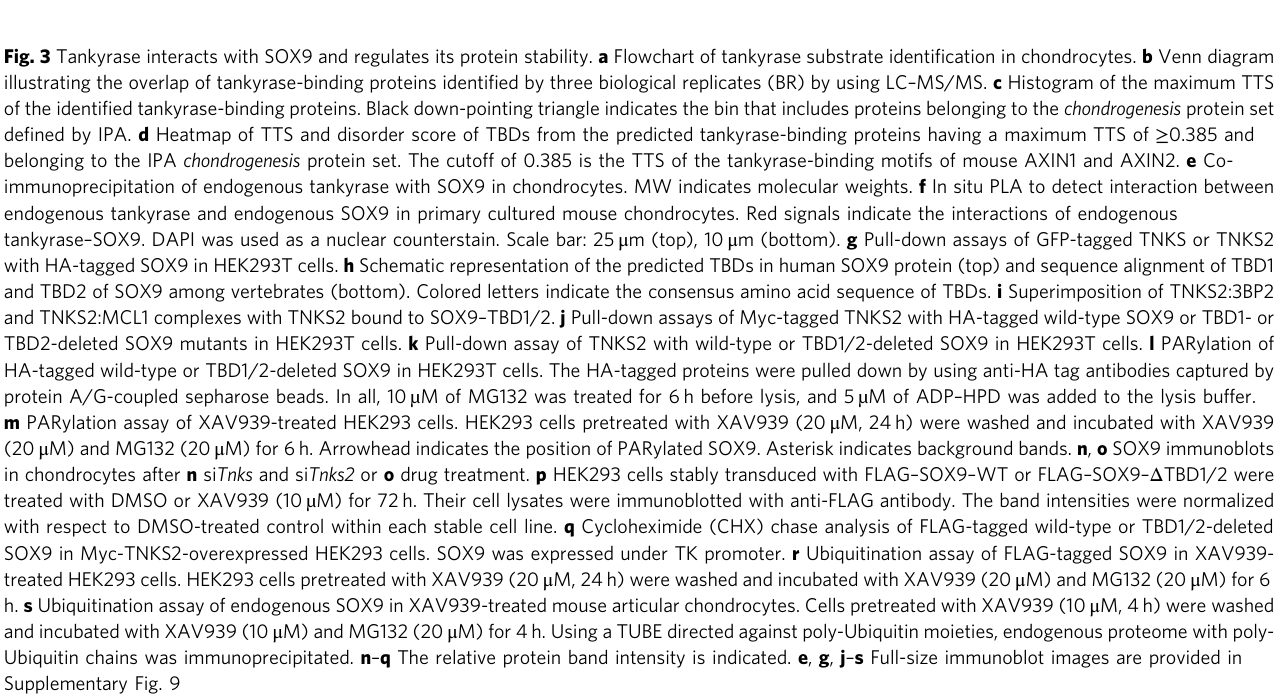
Fig. 3 Tankyrase interacts with SOX9 and regulates its protein stability. a Flowchart of tankyrase substrate identi fi cation in chondrocytes. b Venn diagram illustrating the overlap of tankyrase-binding proteins identi fi ed by three biological replicates (BR) by using LC – MS/MS. c Histogram of the maximum TTS of the identi fi ed tankyrase-binding proteins. Black down-pointing triangle indicates the bin that includes proteins belonging to the chondrogenesis protein set de fi ned by IPA. d Heatmap of TTS and disorder score of TBDs from the predicted tankyrase-binding proteins having a maximum TTS of ≥ 0.385 and belonging to the IPA chondrogenesis protein set. The cutoff of 0.385 is the TTS of the tankyrase-binding motifs of mouse AXIN1 and AXIN2. e Co- immunoprecipitation of endogenous tankyrase with SOX9 in chondrocytes. MW indicates molecular weights. f In situ PLA to detect interaction between endogenous tankyrase and endogenous SOX9 in primary cultured mouse chondrocytes. Red signals indicate the interactions of endogenous tankyrase – SOX9. DAPI was used as a nuclear counterstain. Scale bar: 25 μ m (top), 10 μ m (bottom). g Pull-down assays of GFP-tagged TNKS or TNKS2 with HA-tagged SOX9 in HEK293T cells. h Schematic representation of the predicted TBDs in human SOX9 protein (top) and sequence alignment of TBD1 and TBD2 of SOX9 among vertebrates (bottom). Colored letters indicate the consensus amino acid sequence of TBDs. i Superimposition of TNKS2:3BP2 and TNKS2:MCL1 complexes with TNKS2 bound to SOX9 – TBD1/2. j Pull-down assays of Myc-tagged TNKS2 with HA-tagged wild-type SOX9 or TBD1- or TBD2-deleted SOX9 mutants in HEK293T cells. k Pull-down assay of TNKS2 with wild-type or TBD1/2-deleted SOX9 in HEK293T cells. l PARylation of HA-tagged wild-type or TBD1/2-deleted SOX9 in HEK293T cells. The HA-tagged proteins were pulled down by using anti-HA tag antibodies captured by protein A/G-coupled sepharose beads. In all, 10 µ M of MG132 was treated for 6 h before lysis, and 5 µ M of ADP – HPD was added to the lysis buffer. m PARylation assay of XAV939-treated HEK293 cells. HEK293 cells pretreated with XAV939 (20 μ M, 24 h) were washed and incubated with XAV939 (20 μ M) and MG132 (20 μ M) for 6 h. Arrowhead indicates the position of PARylated SOX9. Asterisk indicates background bands. n , o SOX9 immunoblots in chondrocytes after n si Tnks and si Tnks2 or o drug treatment. p HEK293 cells stably transduced with FLAG – SOX9 – WT or FLAG – SOX9 – Δ TBD1/2 were treated with DMSO or XAV939 (10 µ M) for 72 h. Their cell lysates were immunoblotted with anti-FLAG antibody. The band intensities were normalized with respect to DMSO-treated control within each stable cell line. q Cycloheximide (CHX) chase analysis of FLAG-tagged wild-type or TBD1/2-deleted SOX9 in Myc-TNKS2-overexpressed HEK293 cells. SOX9 was expressed under TK promoter. r Ubiquitination assay of FLAG-tagged SOX9 in XAV939- treated HEK293 cells. HEK293 cells pretreated with XAV939 (20 μ M, 24 h) were washed and incubated with XAV939 (20 μ M) and MG132 (20 μ M) for 6 h. s Ubiquitination assay of endogenous SOX9 in XAV939-treated mouse articular chondrocytes. Cells pretreated with XAV939 (10 μ M, 4 h) were washed and incubated with XAV939 (10 μ M) and MG132 (20 μ M) for 4 h. Using a TUBE directed against poly-Ubiquitin moieties, endogenous proteome with poly- Ubiquitin chains was immunoprecipitated. n – q The relative protein band intensity is indicated. e , g , j – s Full-size immunoblot images are provided